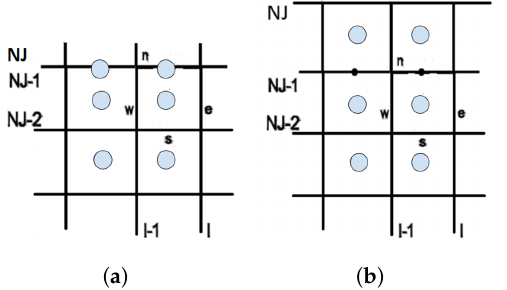
Figure 4. A typical finite volume near the North boundary of the: ( a ) CFD grid, ( b ) PIV